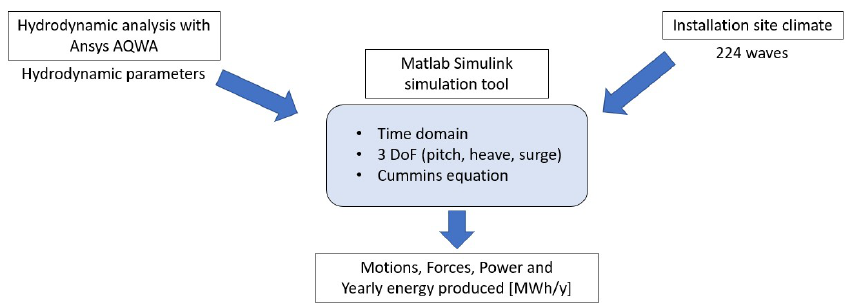
Figure 3. Simulation tool working